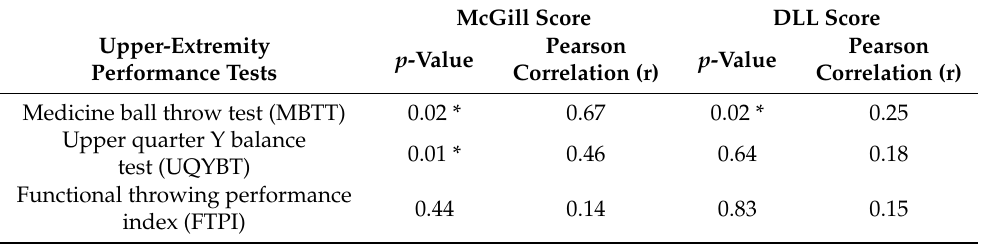
Table 3. Correlation between core stability test scores and upper-extremity performance test